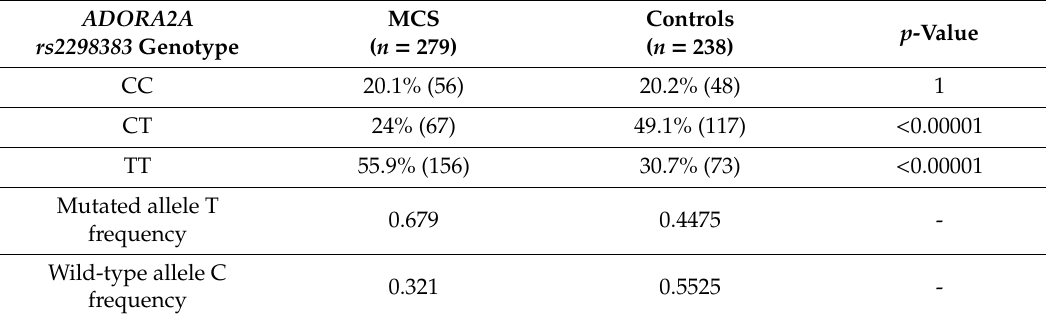
Table 1. Prevalence of ADORA2A rs2298383 SNP in MCS patients and healthy subjects.